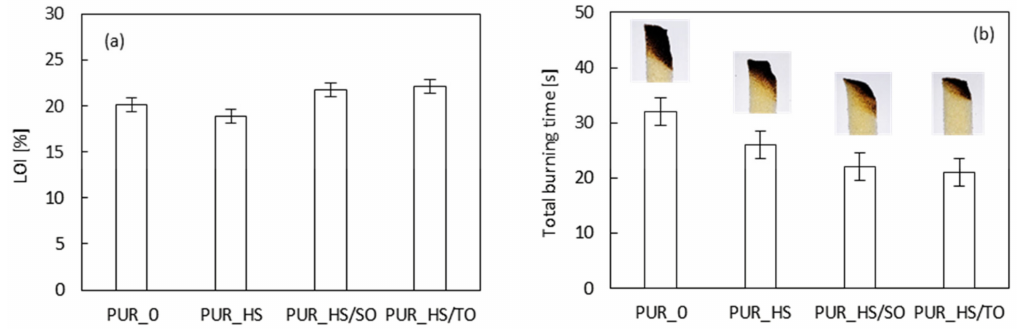
Figure 11. ( a ) LOI and ( b ) total burning time of PUR